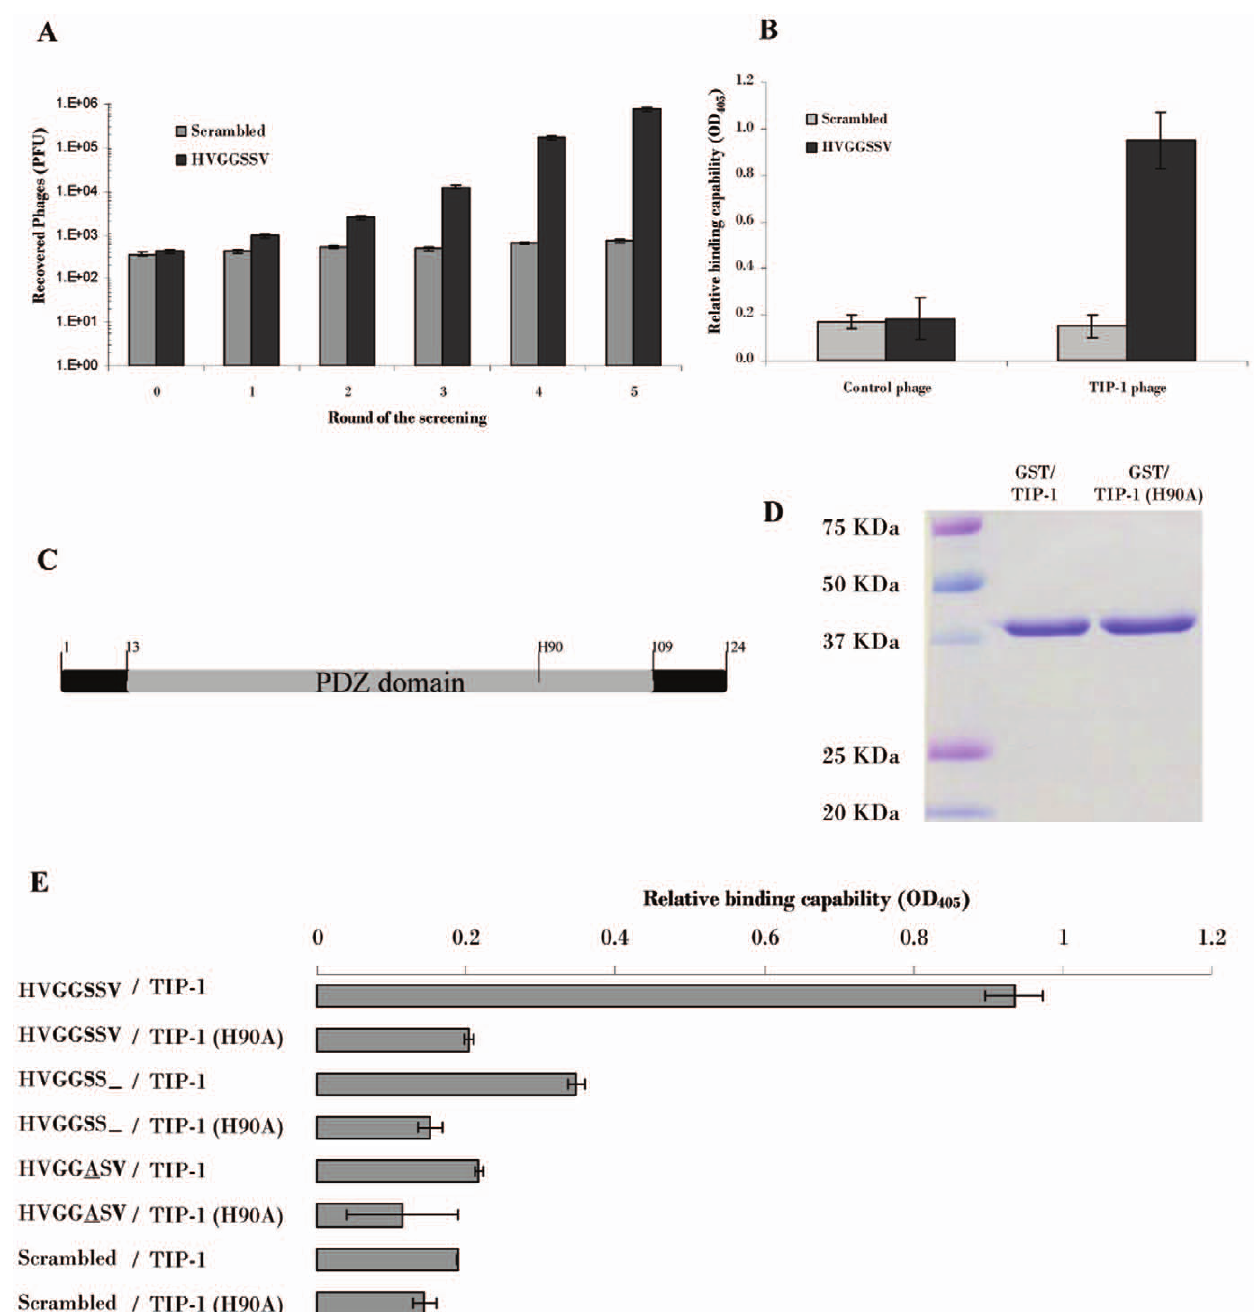
Figure 1. HVGGSSV peptide binds to PDZ domain of the TIP-1 protein. A : Enrichment of phages with selective binding to the HVGGSSV peptide. Phages recovered from the five rounds of screening and those from the original phage library were subjected to selectivity analysis on beads coated with the HVGGSSV peptide or a scrambled peptide control, respectively. Shown are number (PFU) of phages recovered from the beads after the free phages were washed off. 10 9 PFU of phages were used in this assay. B : Specificity of the TIP-1-expressing phage to the HVGGSSV peptide. C : Diagram of TIP-1 protein shows location of PDZ domain and the critical amino acid (H90) for PDZ ligand binding; D : SDS-PAGE image shows purity of the recombinant TIP-1 proteins and a dysfunctional mutant TIP-1 (H90A). The fusion proteins ( , 37 kD) were analyzed along with molecular weight markers. E : Relative association of the purified recombinant proteins to the synthetic peptides was evaluated with ELISA. In these assays, 100 ng of the purified GST/TIP-1 or GST/TIP-1(H90A) proteins were used per wells, all the synthetic peptides were used as 50 ng per well. The mutations in the PDZ binding motif were underlined. Shown are representative data from triplicate experiments. * p , 0.05, n =3, the Student’s t -test. doi:10.1371/journal.pone.0012051.g001 H460 lung cancer cells and HUVEC cells to study the IR-induced level after IR in all the three tested cells (data not showed). However, TIP-1 translocation onto the cell surface. Western blot analysis of the flow cytometric analysis showed that percentage of the H460 cells whole cell lysates did not show dramatic changes in the TIP-1 protein with TIP-1 expression on the cell surface was elevated from basal